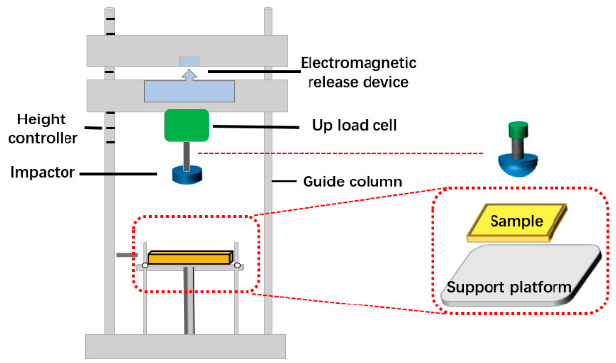
Figure 2. Drop-weight impact tester.